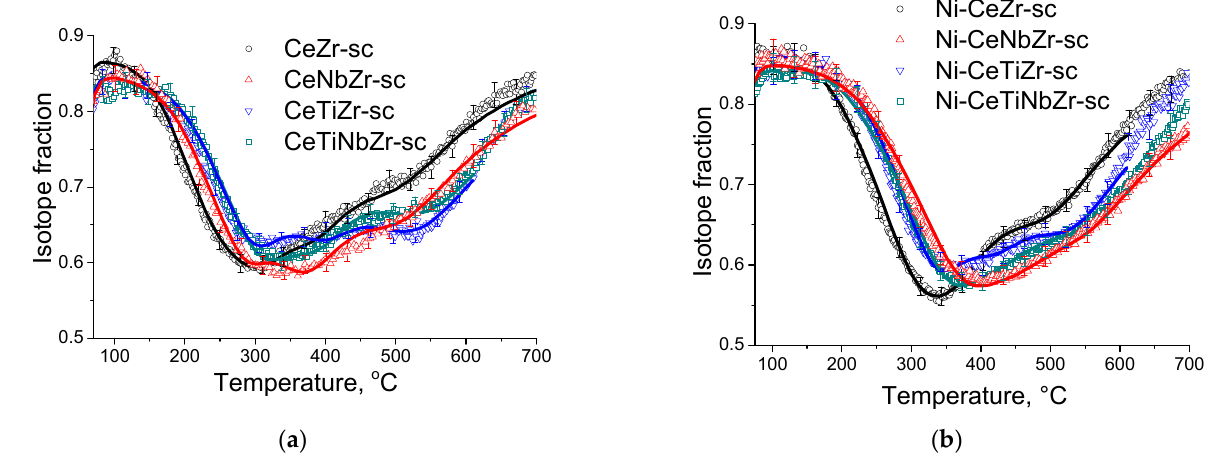
Figure 5. The TPIE curves for supports ( a ) and catalysts ( b ) prepared by supercritical synthesis. TPIE curves for the Ni-containing catalysts shift towards the higher temperature region compared to those for supports, which makes evidence of slowing the rate of oxygen isotope substitution in the samples (Figure 5b). Average weighted oxygen tracer diffusion coefficient D over and non-uniformity coefficient β significantly decrease after Ni